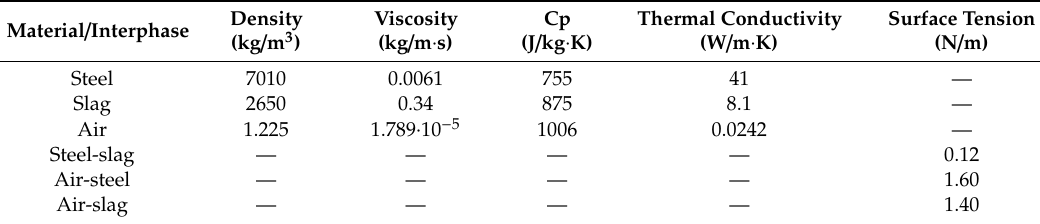
Figure 3. Mesh distribution of the five-strand tundish. Table 2. The thermo-physical properties of the three-phase